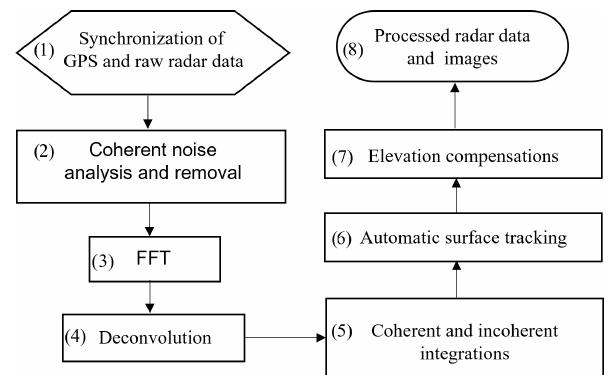
Figure 2. Flowchart of main data processing